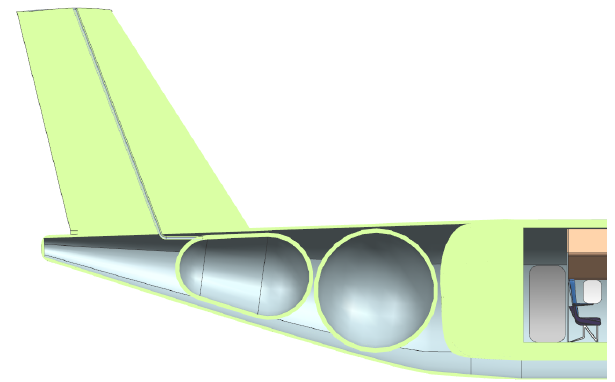
Figure 11. Cross-sectional view of the rear fuselage section showcasing the fuel tank arrangement; venting line routed through the vertical stabilizer.